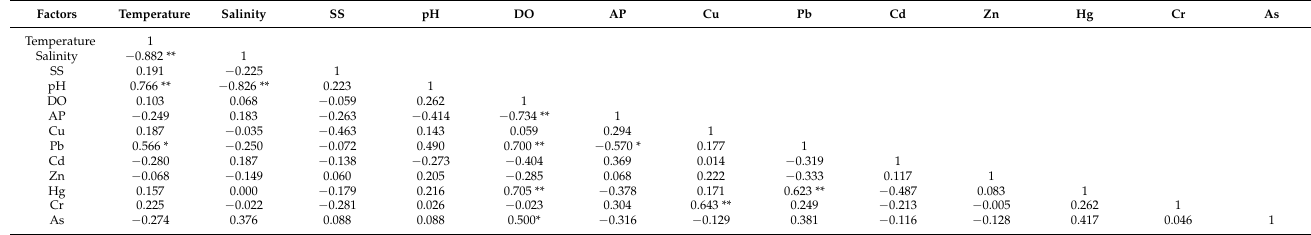
Table 4. Correlation analysis between factors in bottom